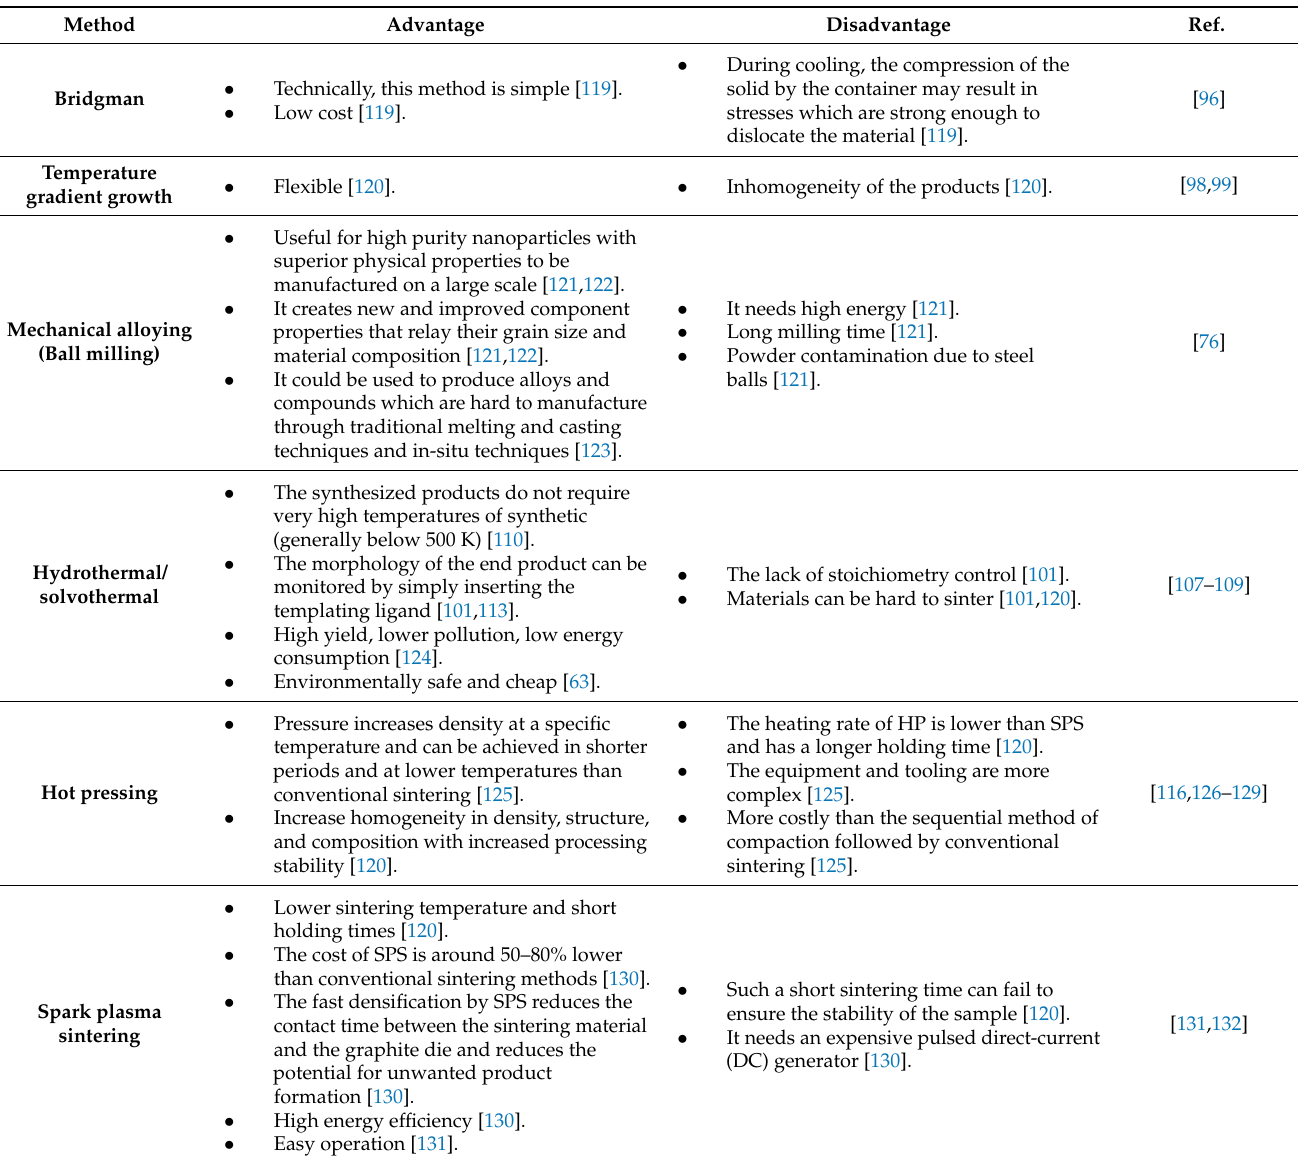
Table 2. Summary of advantages and disadvantages of synthesis and post-treatment synthesis methods.